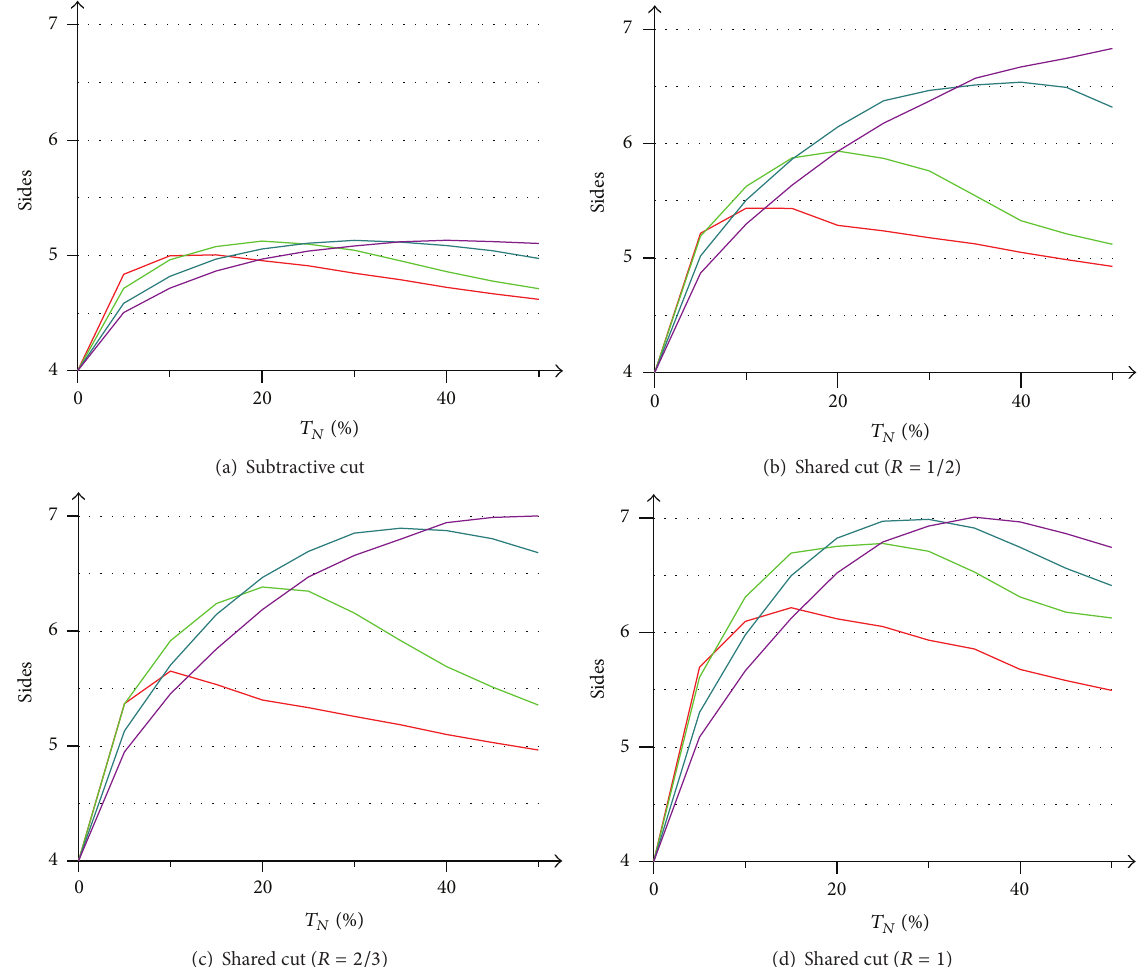
Figure 7: Average number of sides per tile. Colors represent several 𝑅 𝑁 values: 1/4, 1/3, 1/2, and 1.